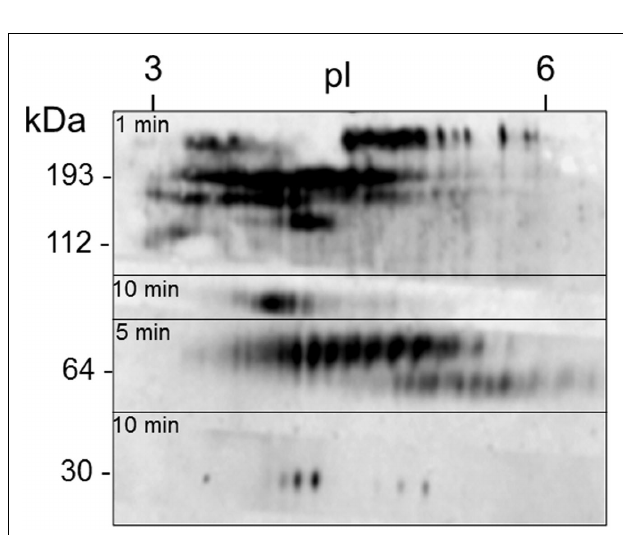
FIGURE 11 |A single sea urchin can have as many as 264 spots that are Sp185/333 + . Coelomic fluid proteins (200 μ g) from sea urchin 12 (see Figure 12 ) were separated by 2D electrophoresis and transferred to a filter. The filter was immunostained with an equal mixture of the three anti-Sp185/333 sera (see legend to Figure 10 ) and exposed to autoradiographic film for 1, 5, or 10min.The different exposures were merged to give a final composite image. Isoelectric points (pI) are shown at the top and the molecular weight standards (kDa) are shown to the left. Reprinted from Dheilly et al. (2009) with permission from the American Association of Immunologists, Inc., copyright 2009.